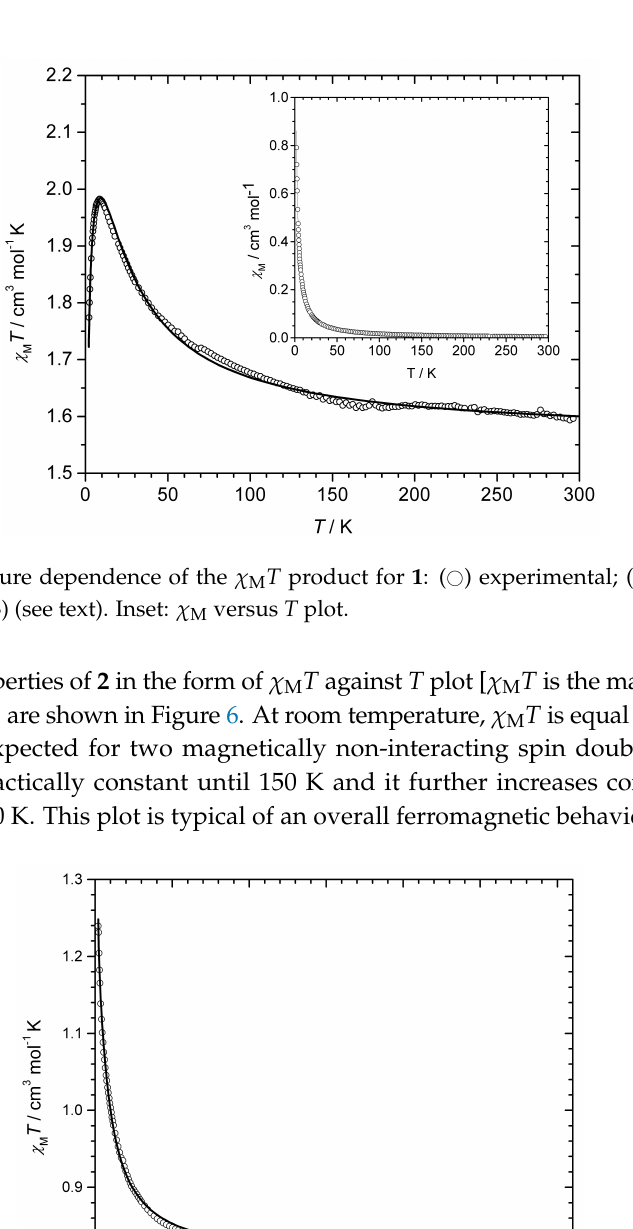
) experimental; ( __ ) best-fit curve (cid:35)